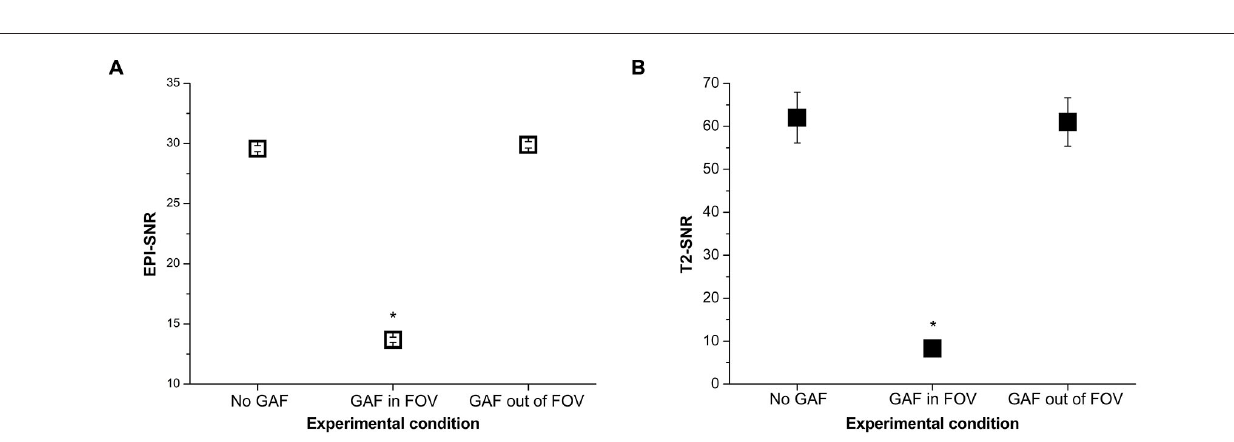
(No GAF: SNR = 49.041 ± 3.349, GAF out of FOV: SNR = 49.037 ± 3.370; t ( 99 ) = 0.20, p =